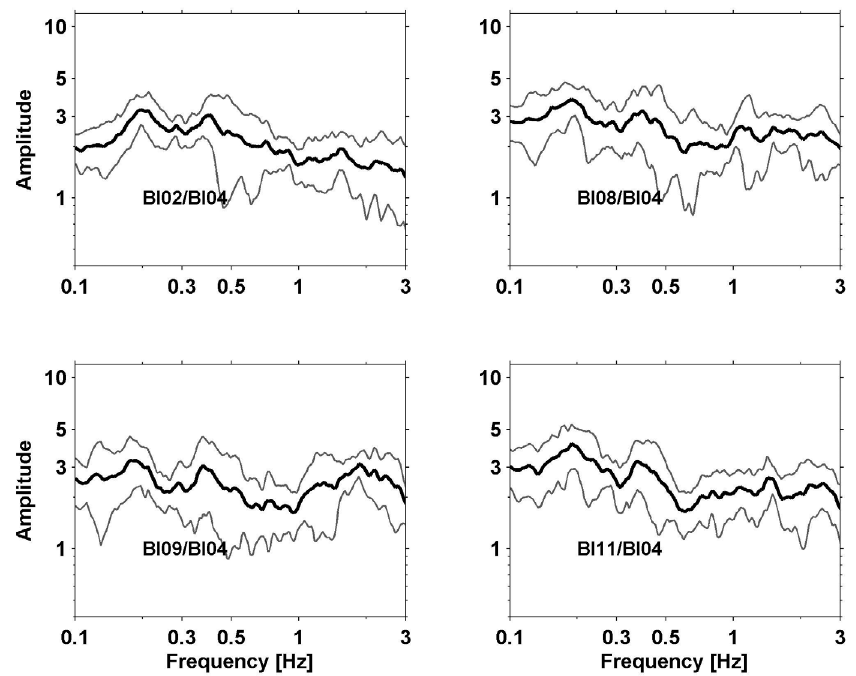
Figure 7. Same as Figure 6 except for locations in the middle of the city (see Figure